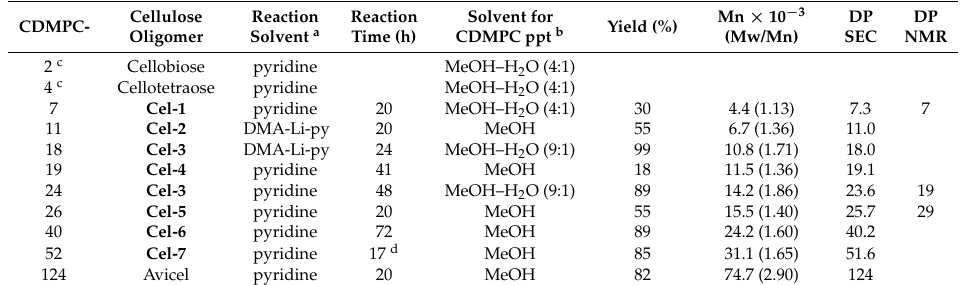
Table 2. Preparation of CDMPC derivatives with the DPs from 2 to